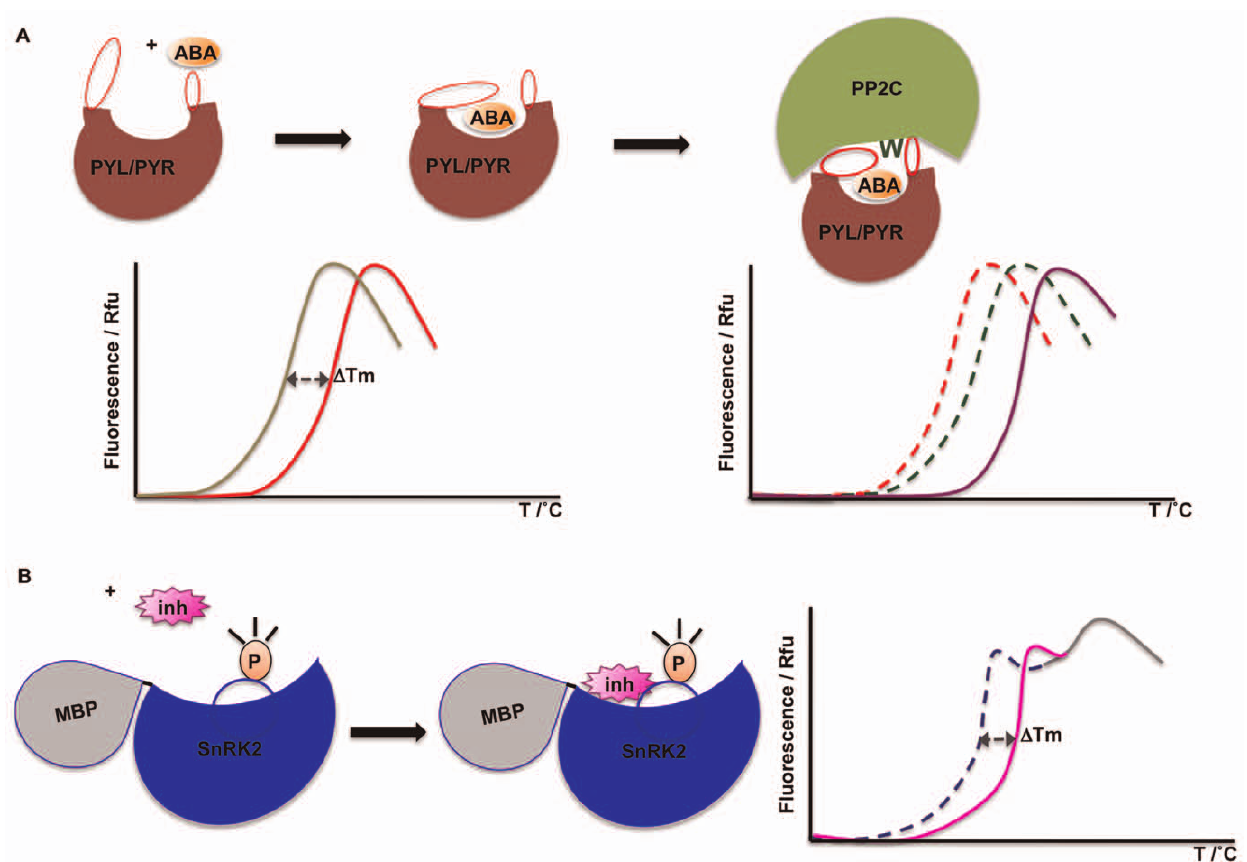
Figure 10. Schematic representation of thermostability profiles corresponding to the various aspects of the signaling pathway. ( A ) Stabilization of receptor by ligand-binding is demonstrated by the shift in the melt curve, and ligand-induced protein-protein interaction results in the formation of a more stable complex that unfolds cooperatively with a Tm higher than that of both individual proteins. ( B ) A SnRK2-MBP fusion protein exhibits a bi-phasic melt curve, of which only the transition curve corresponding to untagged SnRK2 shifts in the presence of SnRK2 inhibitors.